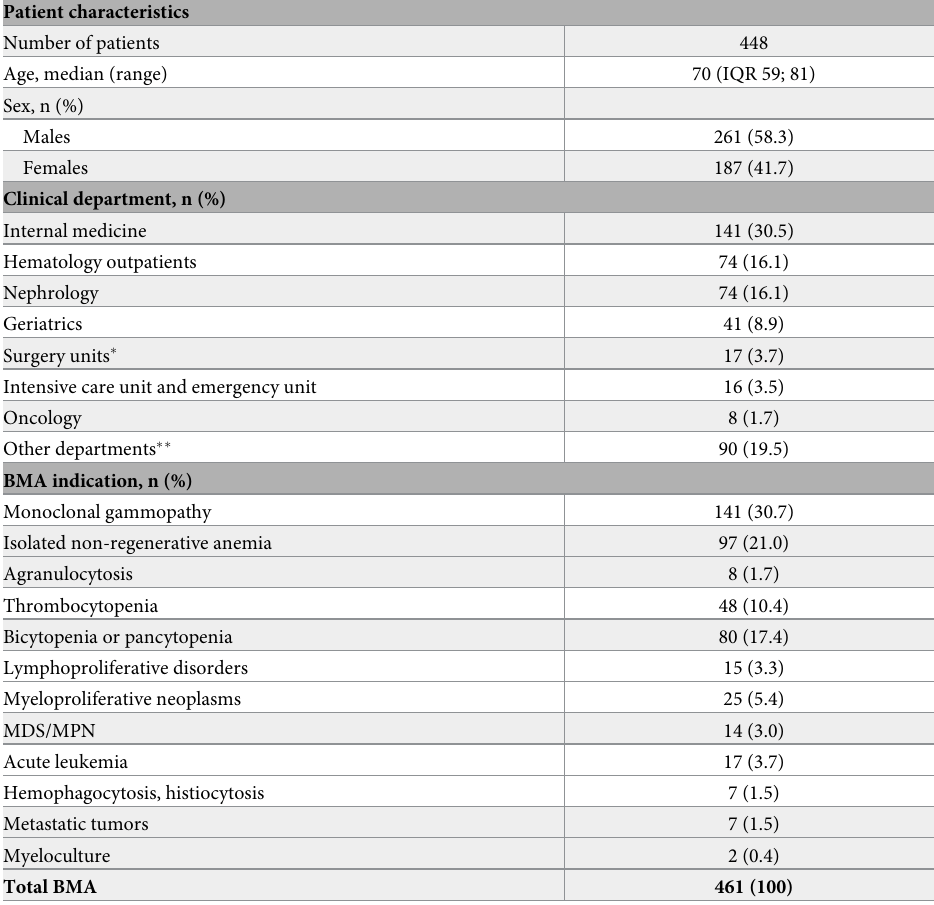
Table 1. Patient characteristics and bone marrow aspiration